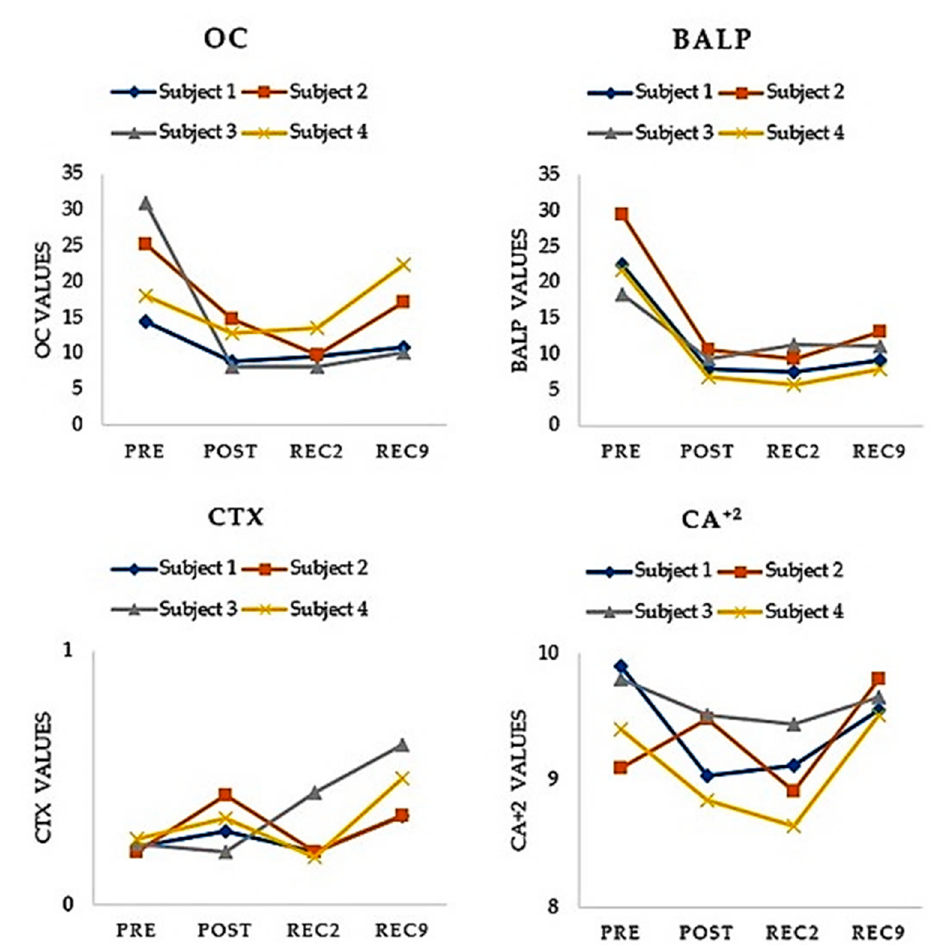
Figure 1. Chronological sequence of serum variables of bone metabolism of each of the 4 subjects. No